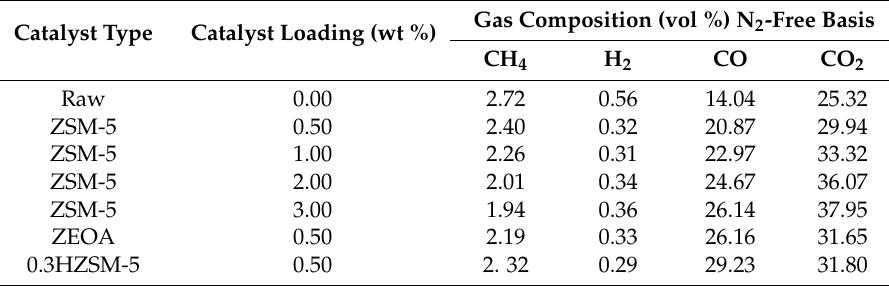
Table 3. Composition of non-condensable